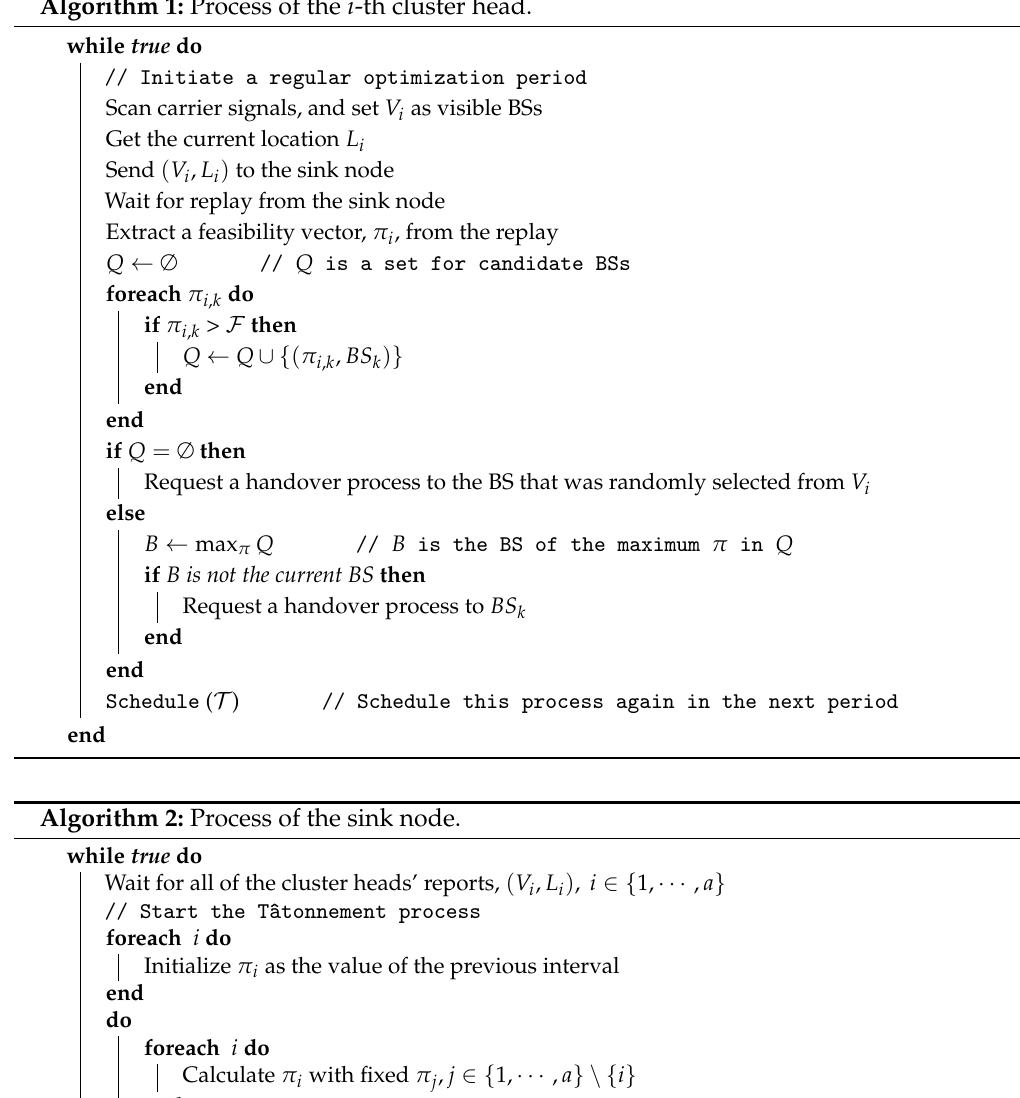
Algorithm 1: Process of the i -th cluster head.